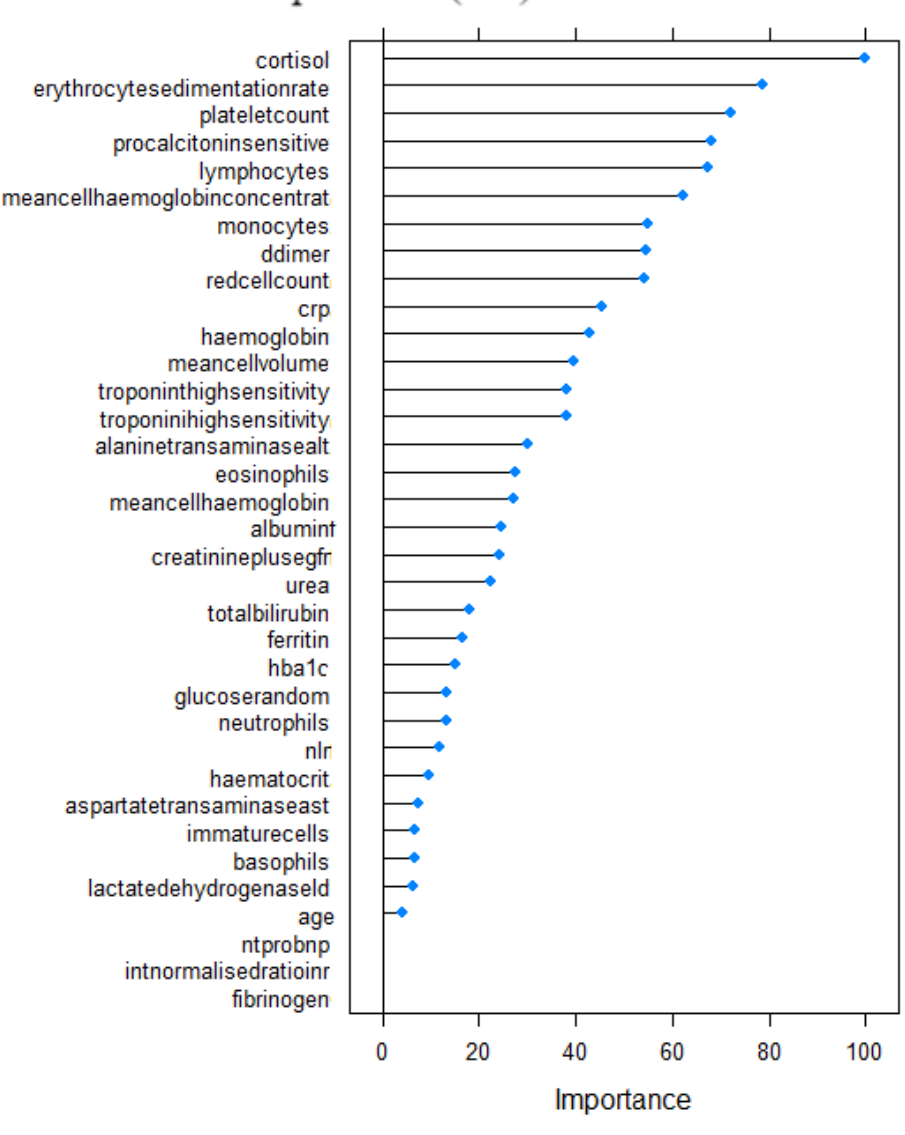
Figure 16. Variable importance for decision tree model on risk